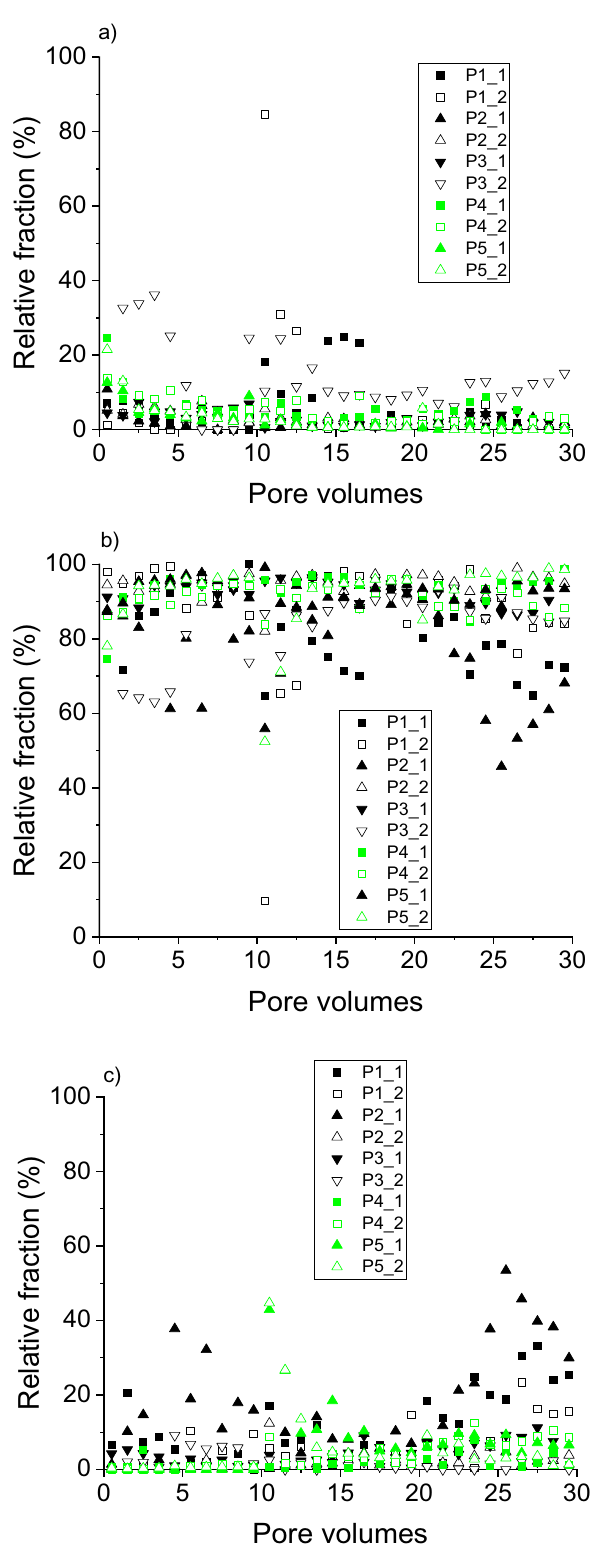
Figure 4. Relative distribution of iron eluted from soils with increasing degrees of podzolisation (P1 to P5) in irrigation experiments between fractions. ( a ) < 1 kDa, ( b ) 1 kDa–0.45 µm, ( c ) > 0.45 µm. ‘_1’ and ‘_2’ denote duplicate